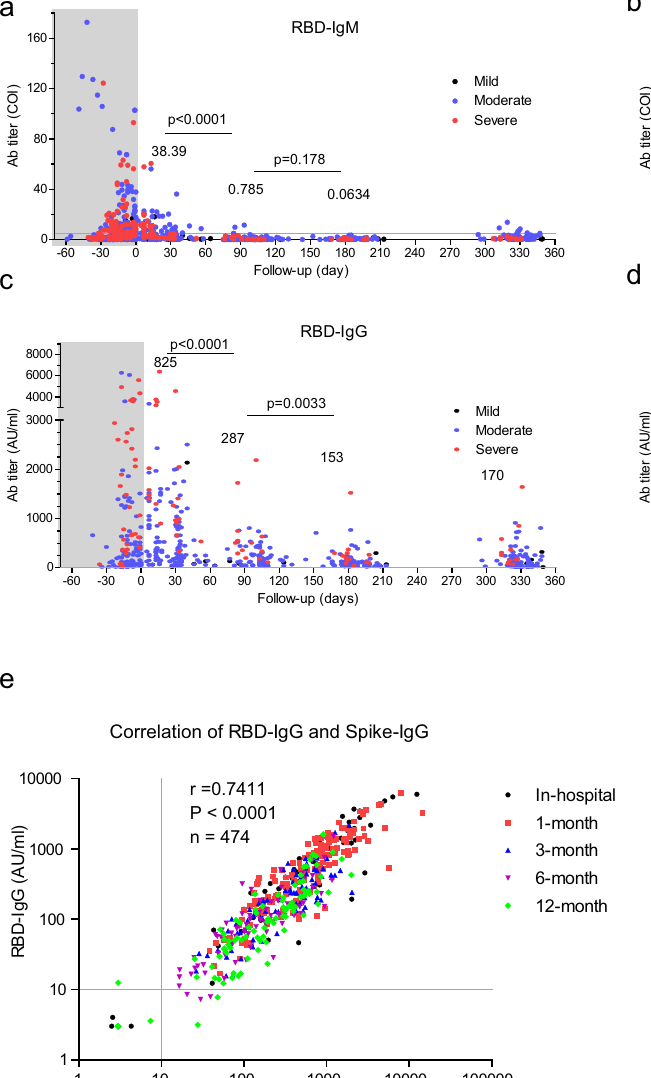
n=13 n=11 n=13 n=12 n=13 n=12 n=10 n=7